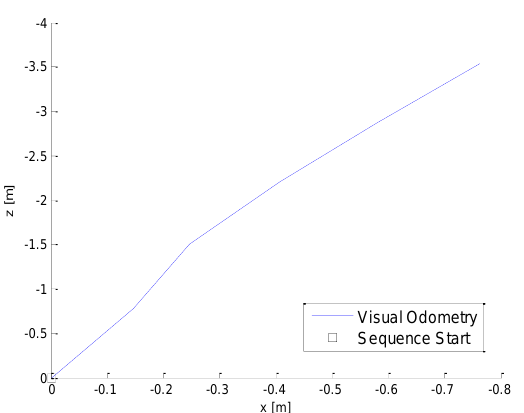
Fig. 15 The result of ARMF-base VO system using the images we captured. In this coordinates, the blue line represents the path calculated by the ARMF-base VO system, and the black point represents the start position.